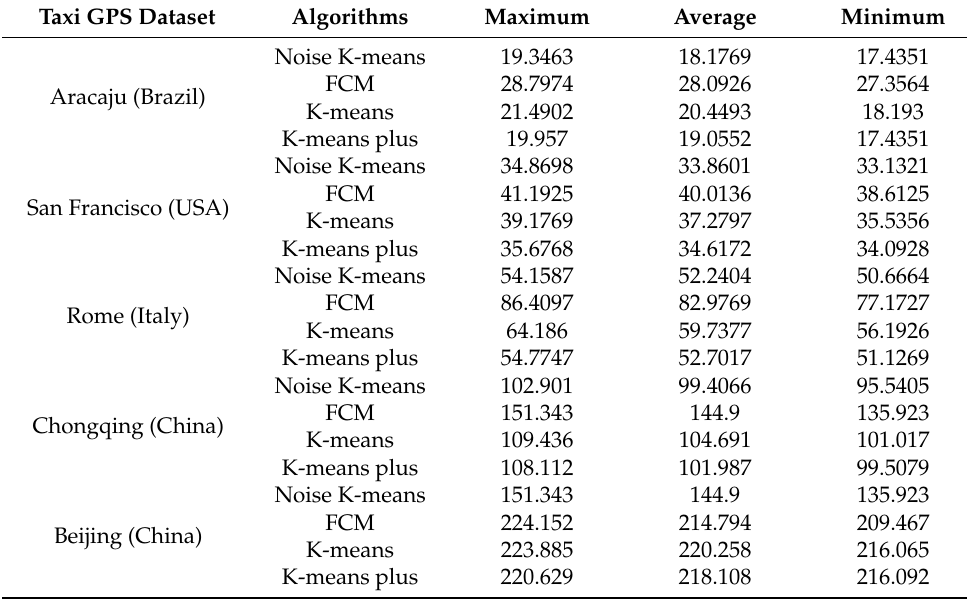
Table 6. Comparison results of SSE evaluation values.